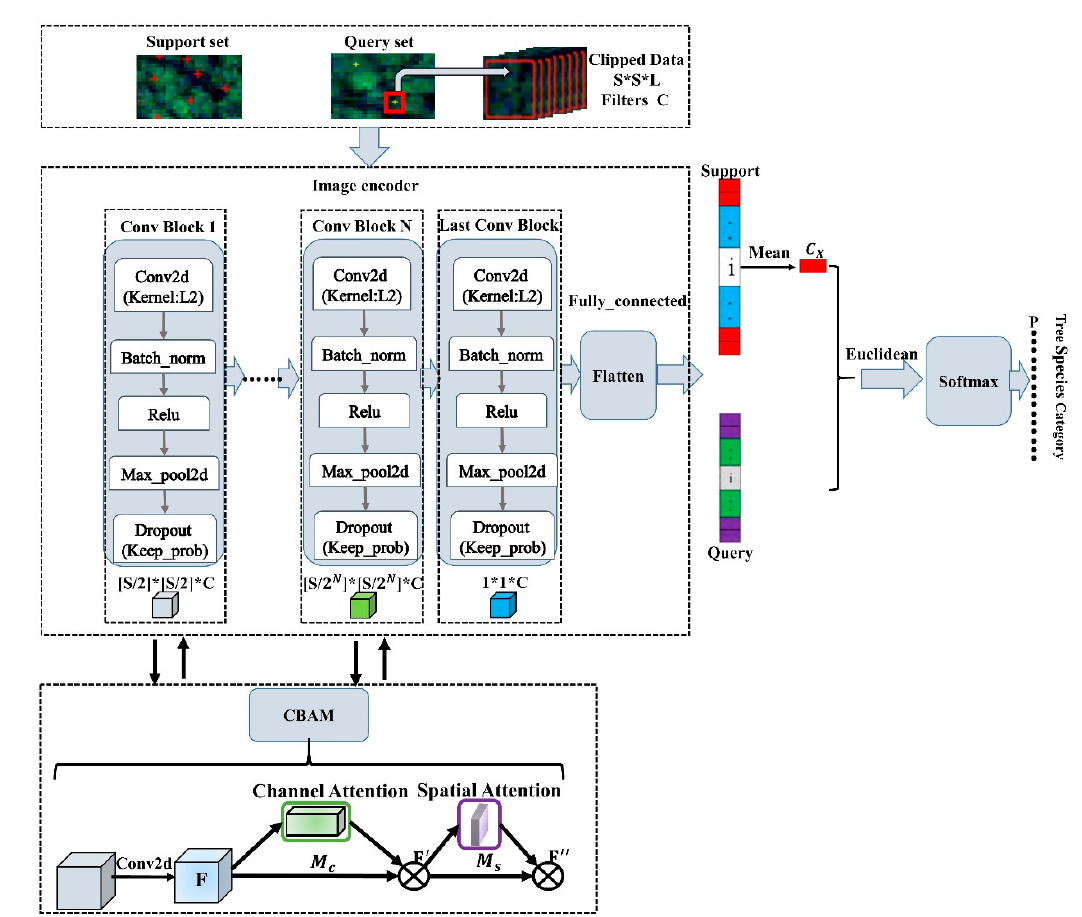
Figure 5. Spatial attention module.